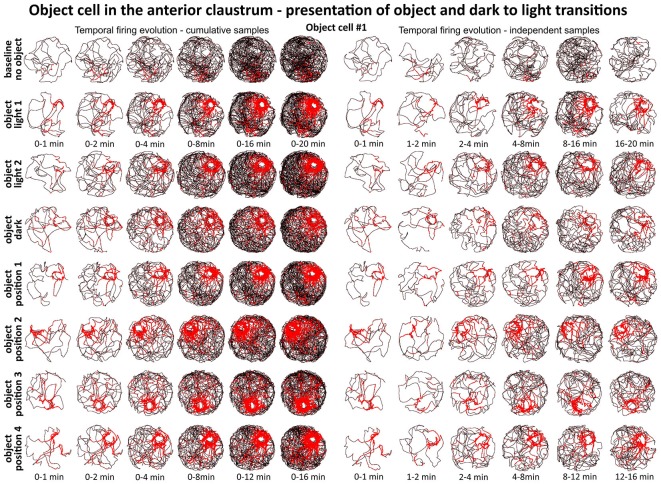
Temporal evolution of firing of claustral object cell #1 from Figure 3. On the left, six samples of cumulative time intervals, and on the right, six samples of independent time intervals presented in rows for recordings in each environmental condition. Sessions were either 16 or 20 min long. The object cell responded through the whole session from the beginning until the end. The visual cue was located in the same place as in Figure 1 in baseline conditions.